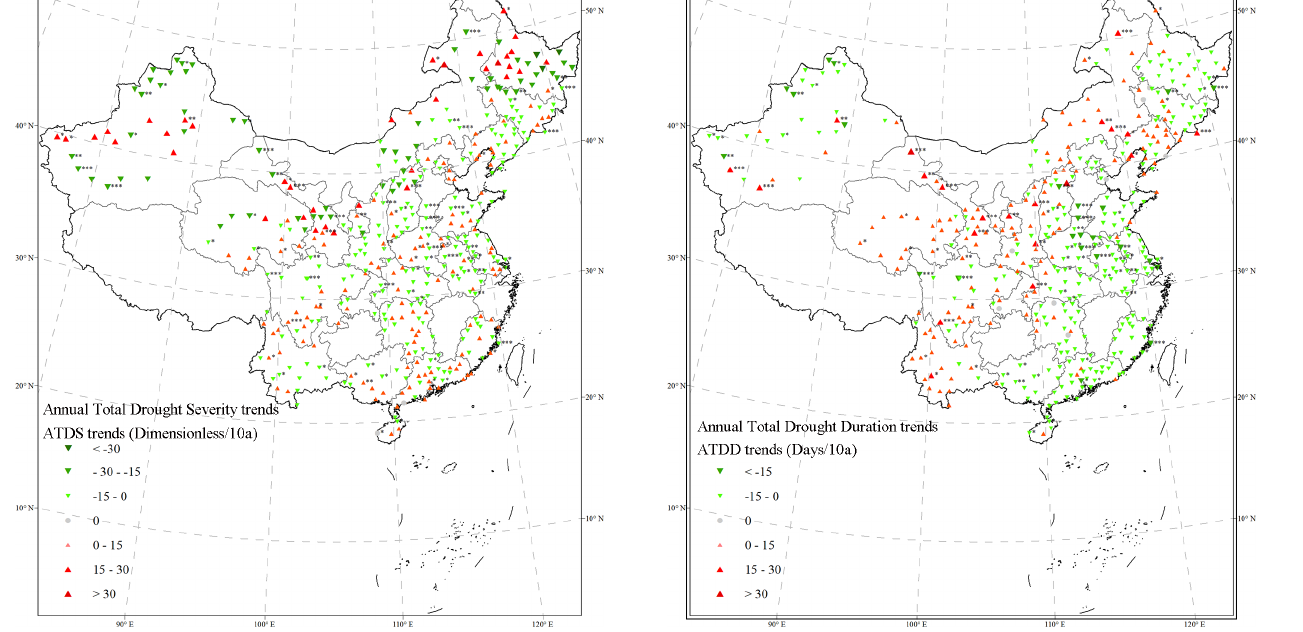
Figure 6. The spatial distribution of the changing trends of ATDS (the red and green triangles indicate increasing and decreasing trends, respectively. “***” denotes P value < 0 . 001, “**” denotes P value < 0 . 01, and “*” denotes P value < 0 . 05).